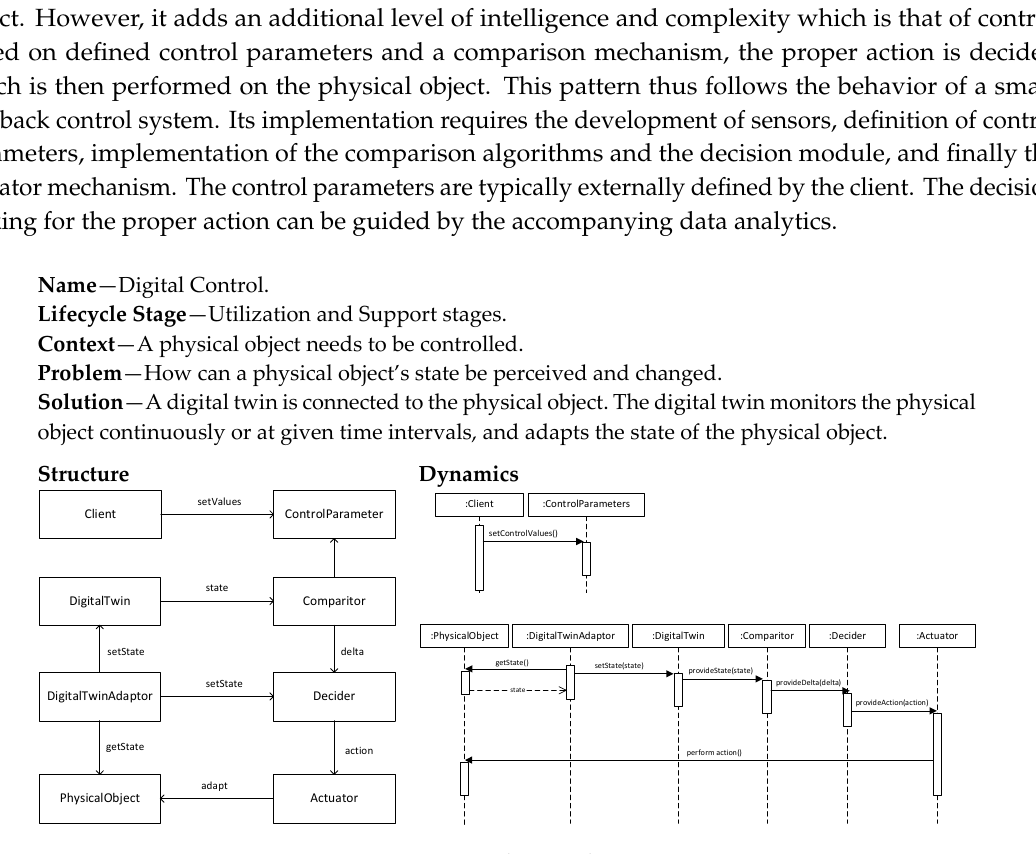
Figure 13. Digital Monitor pattern.